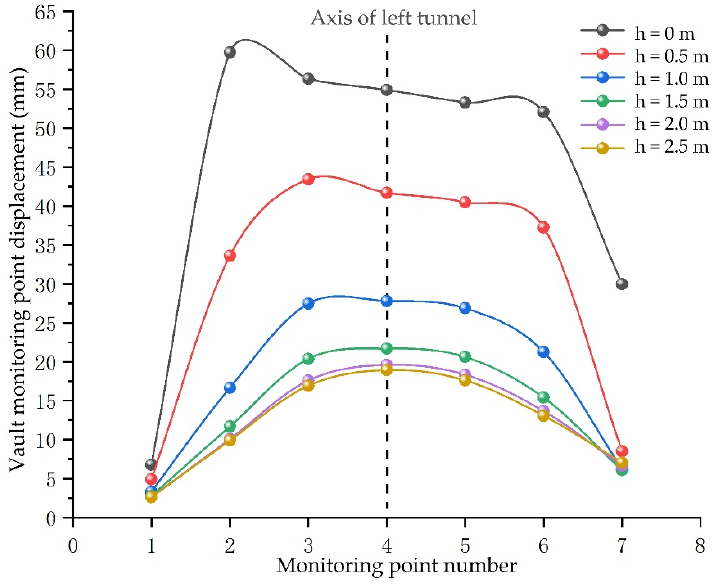
Figure 15. Displacement of 7 monitoring points near the vault of the left tunnel.